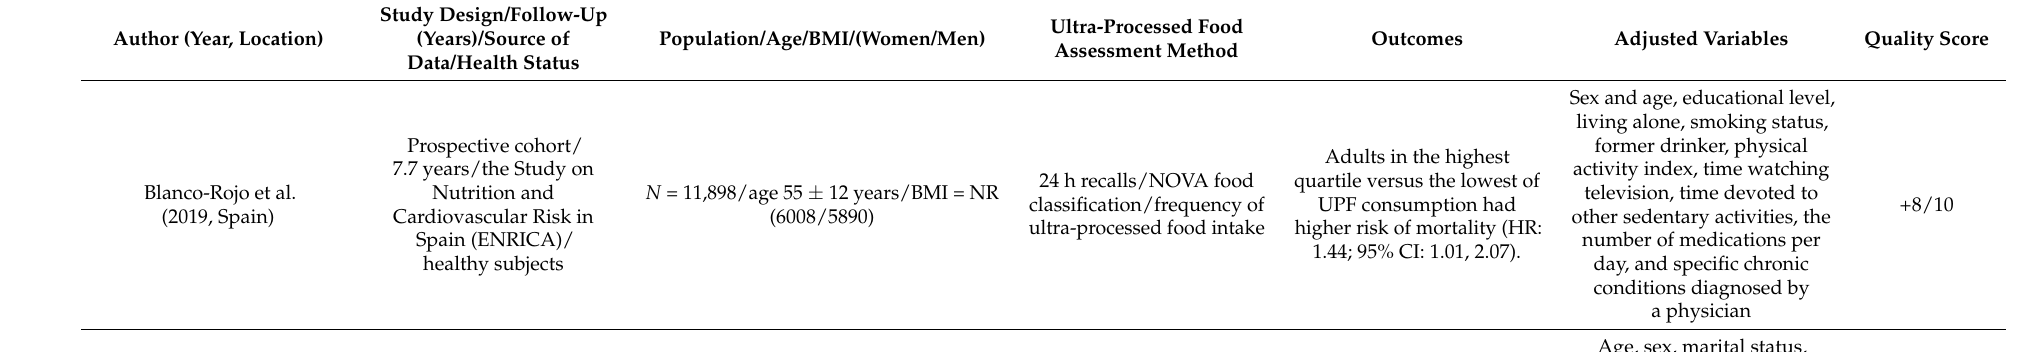
Table 1. Characteristics of included